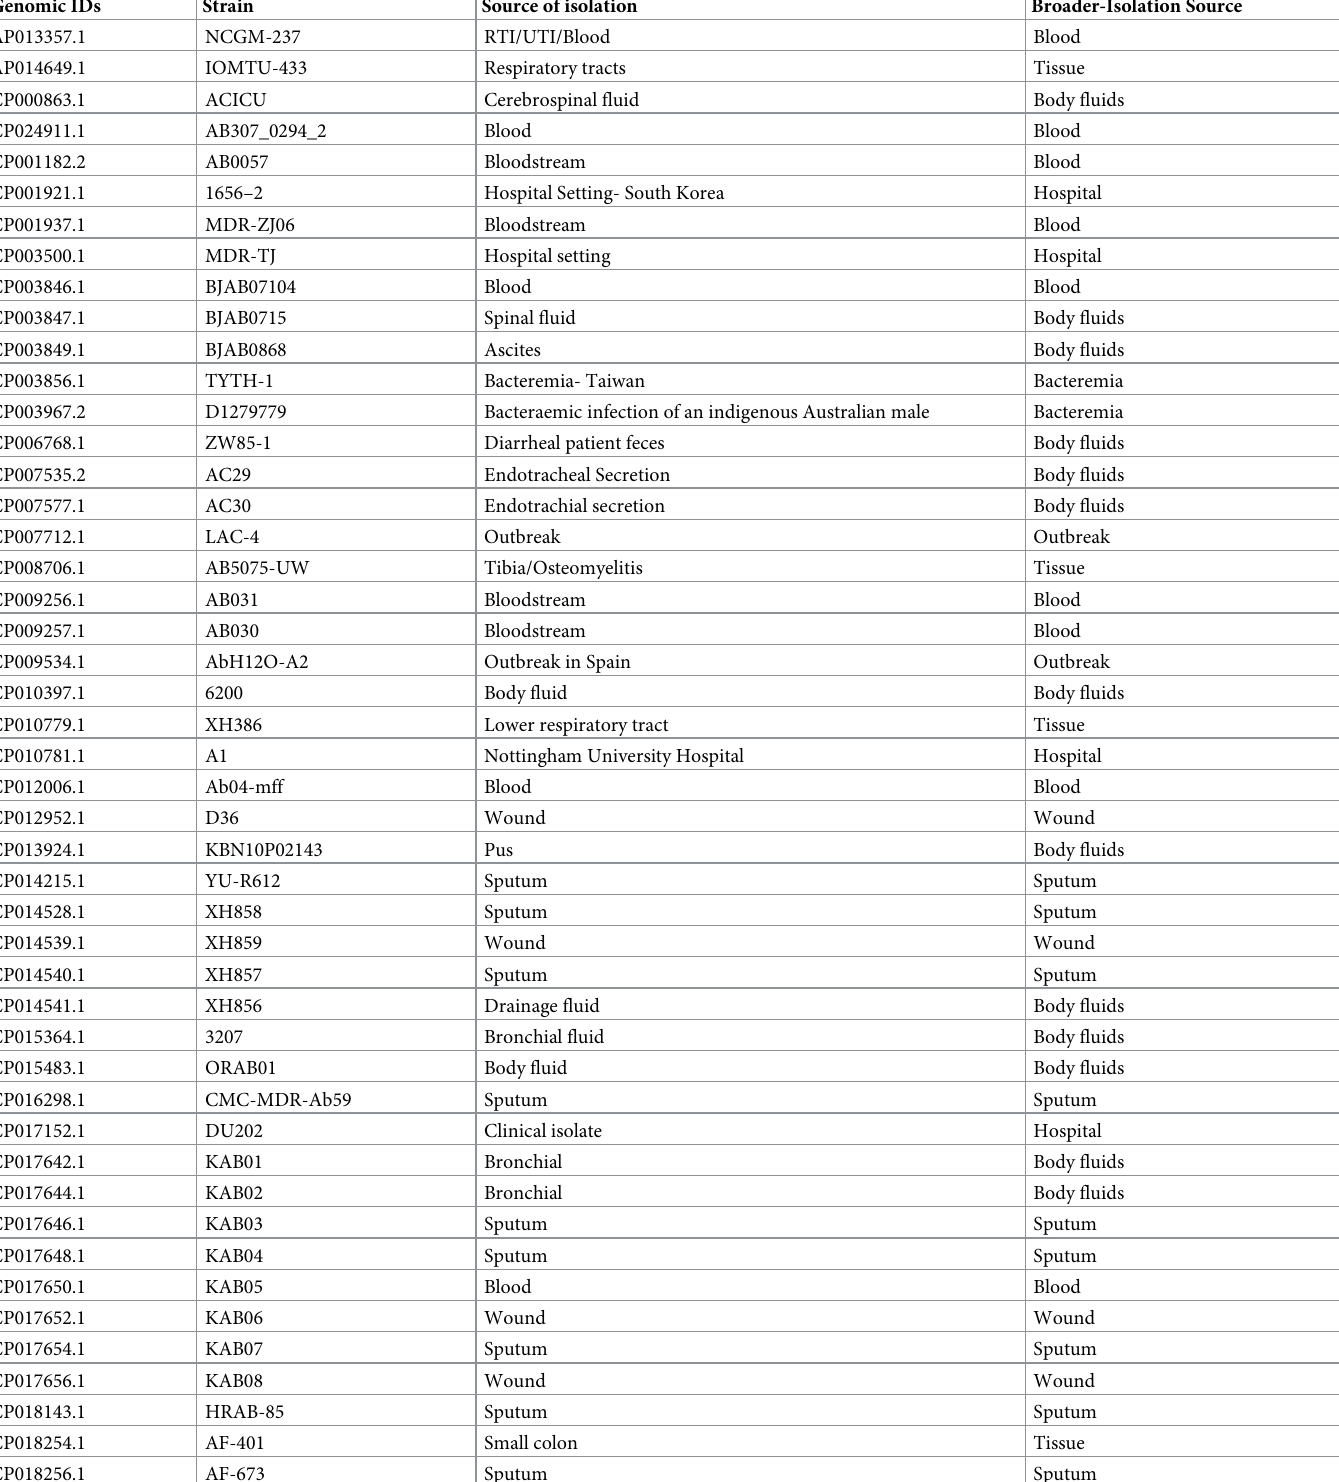
Table 1. List of 78 A . baumannii strains and source of